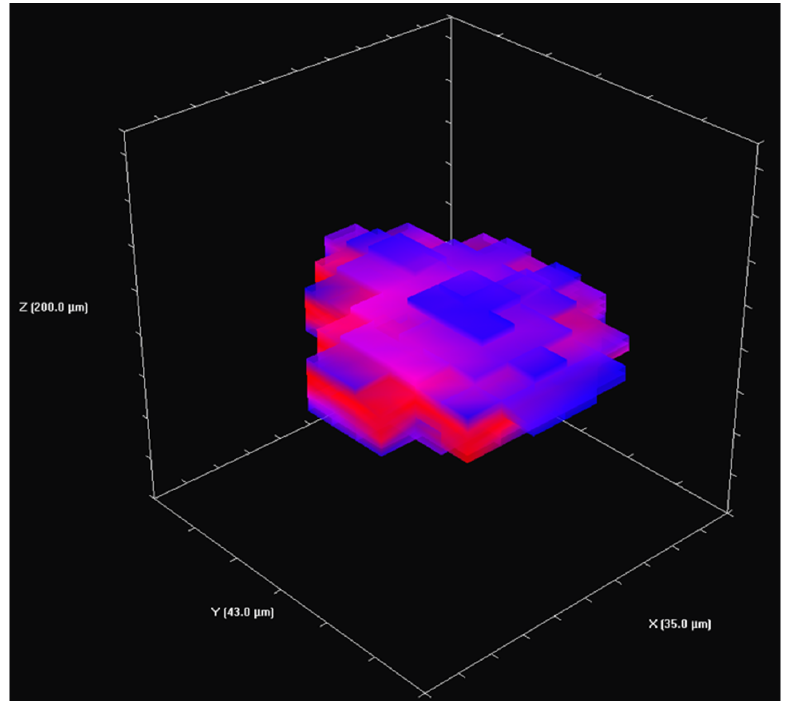
Figure 16. The 3D model of the selected hematite was reconstructed based on the 3D Raman mapping, selecting 1310 cm − 1 as a criterion.